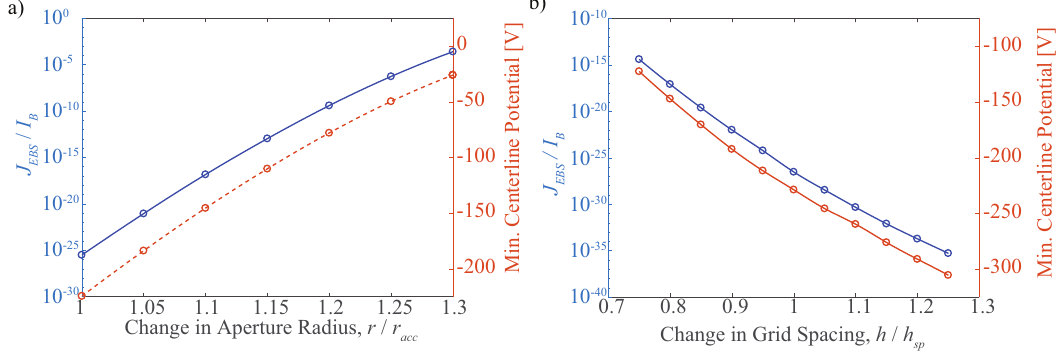
Figure 12. Electron backstreaming (EBS) current fraction and minimum centerline potential for varying ( a ) grid spacing and ( b ) aperture radius, normalized by nominal geometry